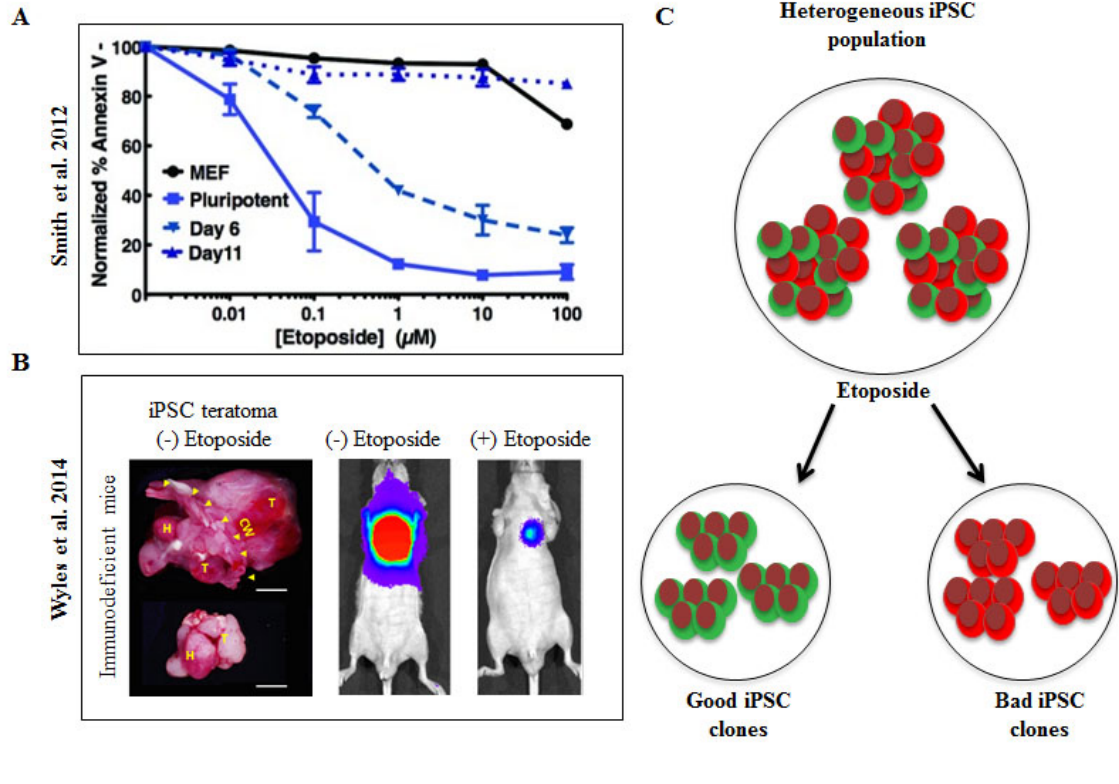
Figure 2. Utilization of genotoxic drug, etoposide, for iPSC therapeutic